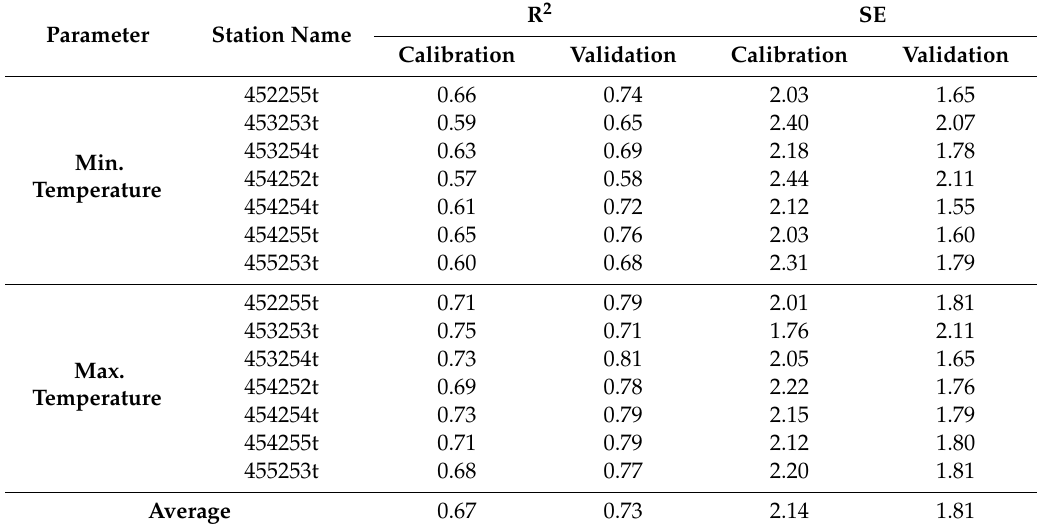
Table 4. R 2 and SE of SDSM- downscaled monthly temperatures for calibration and validation periods.